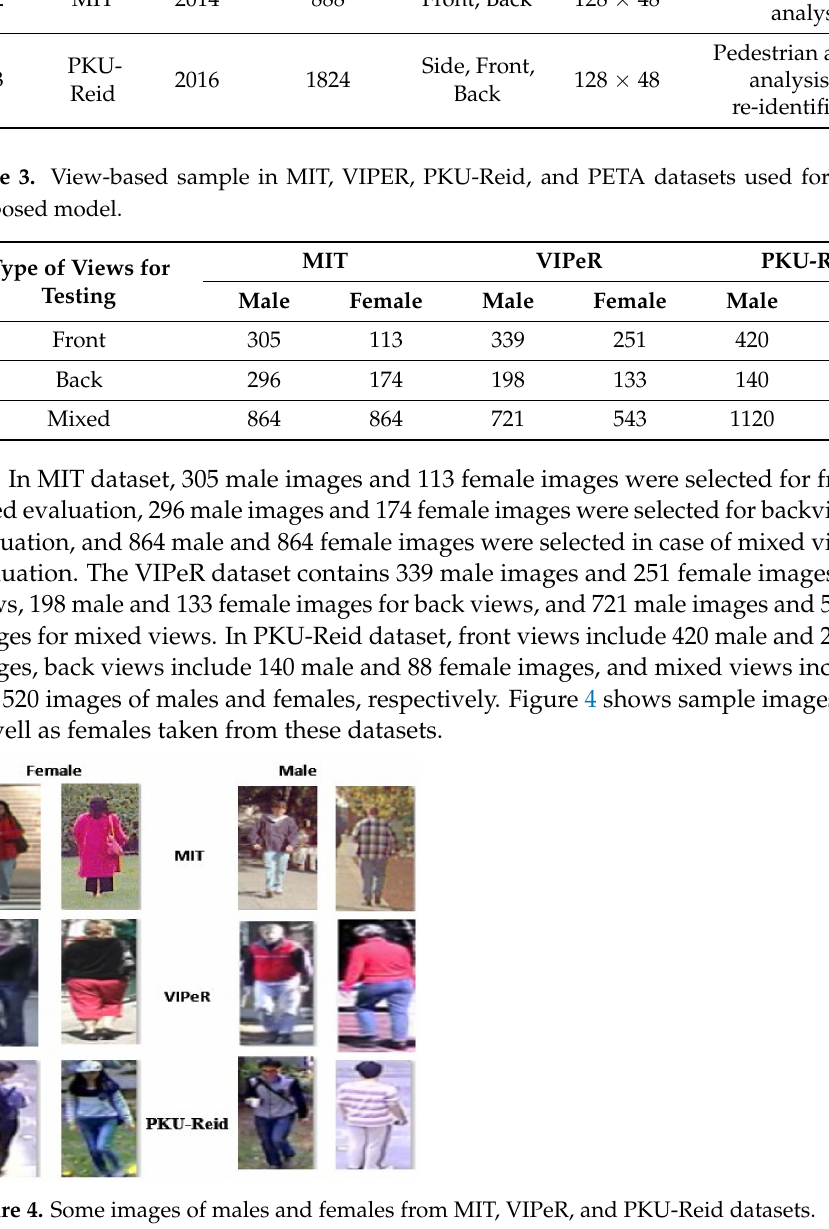
Figure 4. Some images of males and females from MIT, VIPeR, and PKU-Reid